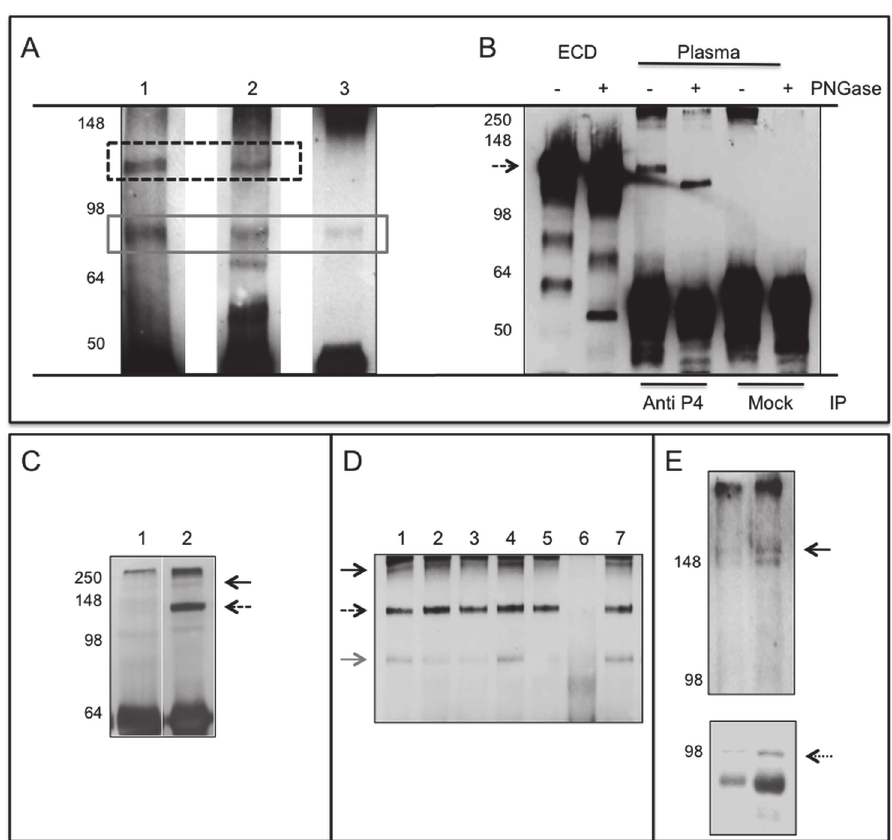
Fig 3. PTPRG plasmatic isoforms. Panel A : Immunoblotting of human plasma samples immunoprecipitated (IP) with Rb anti-P4 and blotted against: Lane 1: Rb anti-P4, lane 2: mouse monoclonal R&D, lane 3: rabbit polyclonal Abcam. Dashed box: * 120 kDa PTPRG isoform, gray solid box: * 90 kDa isoform. Panel B : Immunoblotting with Rb anti-P4 of purified recombinant PTPRG-ECD-Fc lanes 1,2 and immunoprecipitated plasma samples with anti-P4 and RbIgG isotype control (Mock). Sample treated with the deglycosylating enzyme PNGase F are labeled with + sign. Dashed arrow: PTPRG * 120 kDa isoform. Immunoblotting with Rb anti-P4 of anti-P4 IP human plasma ( Panel C ) and mouse serum ( Panel D ) of samples diluted 1:20 in PBS/Tx100 1%. Panel C : Lane 1: Immunoprecipitation with isotype control; Lane, 2: Rb anti-P4. Panel D : Lane 1 – 5 and 7: IP with Rb anti-P4. Lane 6: IP with RbIgG isotype control. Black arrow: full-length protein, dashed arrow: * 120 kDa isoform, gray arrow: * 90 kDa isoform. Left: molecular weight markers. Panel E : Plasma exosomes purified from two individuals were blotted with Rb-anti-P4 (upper panel) and anti ALIX rabbit antibody (lower panel, dotted arrow), an exosome marker. A band corresponding to full- length PTPRG is detectable in both samples (black arrow). Left: molecular weight marker. ( Fig. 4C , left panel). The * 90 kDa band reacted with an Abcam antibody recognizing the jux- tamembrane intracellular domain, thus indicating that epitopes located on both sides of the transmembrane region are present in this isoform that is absent in the * 120 kDa isoform ( Fig. 4C , right panel).